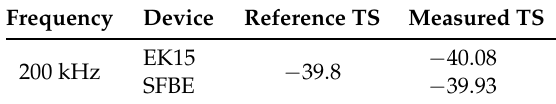
Figure 18. Histogram of TS measured around the target for EK15 ( left ) and SFBE ( right ). Table 7. TS (dB) of 36.4 mm tungsten sphere in fresh